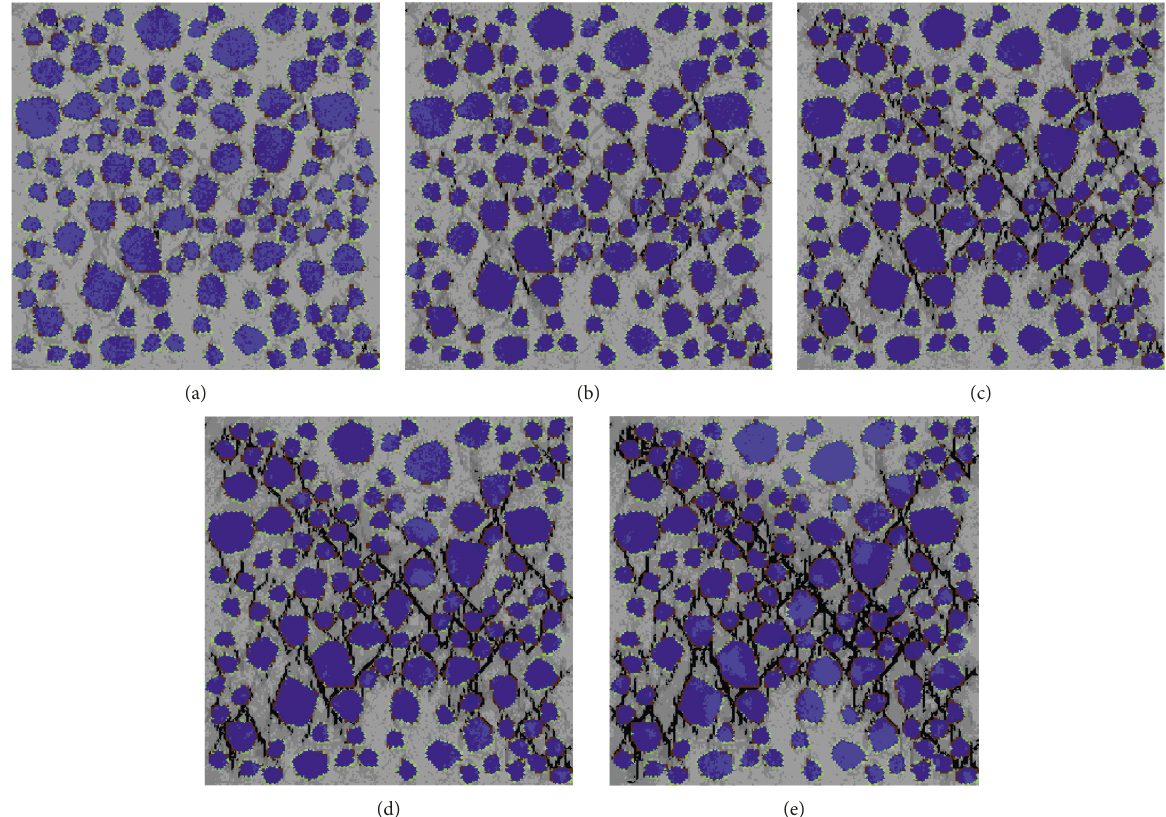
Figure 25: Failure patterns of concrete under different end friction constraints.